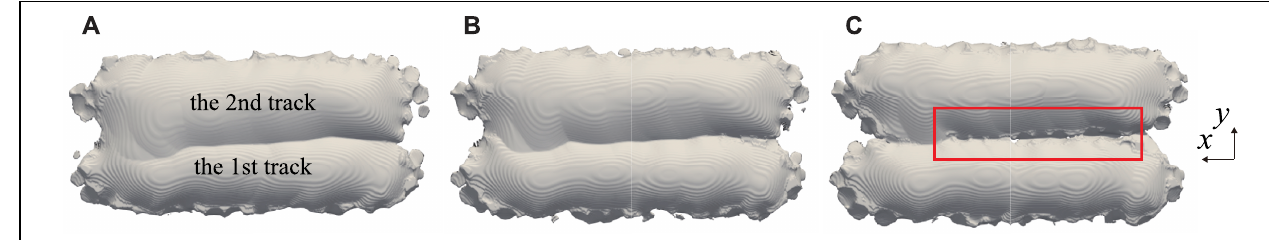
FIGURE 9 | The bottom morphology of the melt tracks with different hatching distance (A) : 0.28 mm, (B) : 0.32 mm, (C) : 0.36